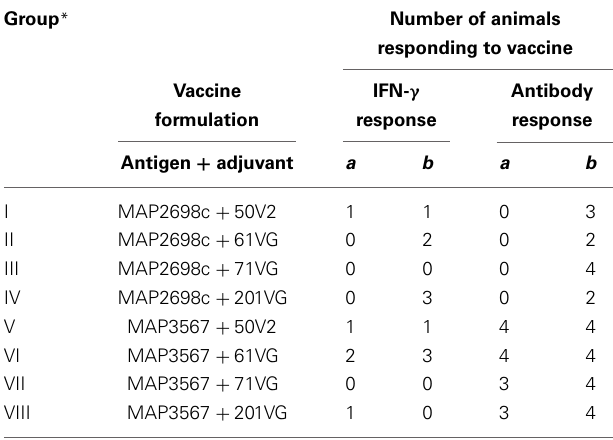
Table 1 | Number of animals with cellular (IFN- γ SP% > 38%) and humoral immune (antibody SP% > 70%) responses to recombinant antigen